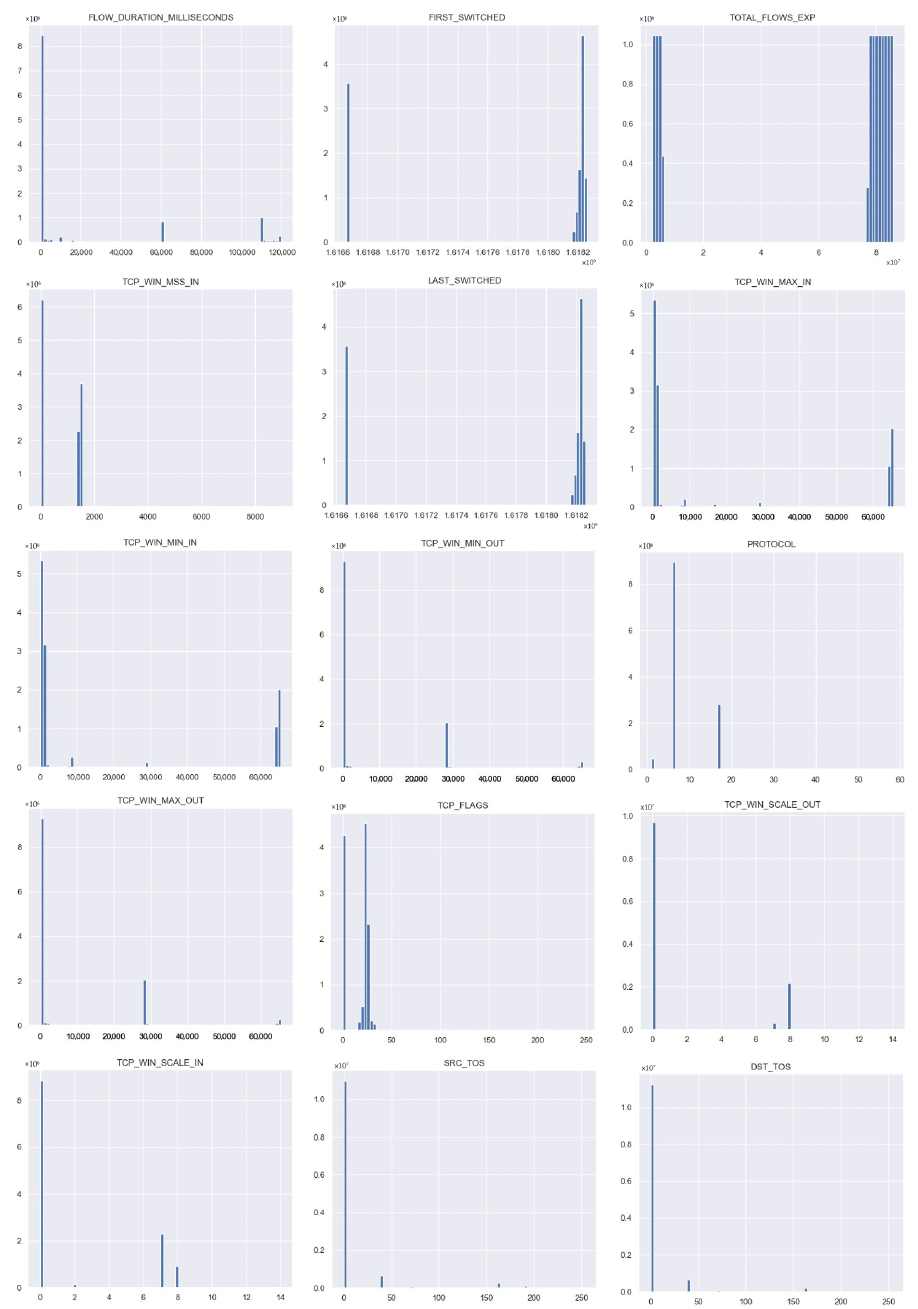
Figure 4. Distribution plots of the 15 most important